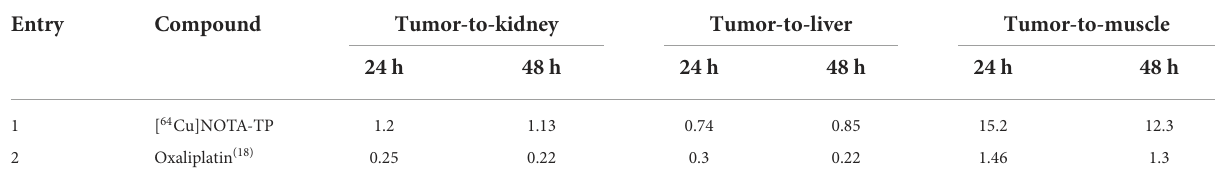
TABLE 1 Selectivity index (or therapeutic window) of [ 64 Cu]NOTA-TP relative to standard platinum compounds in clinic.